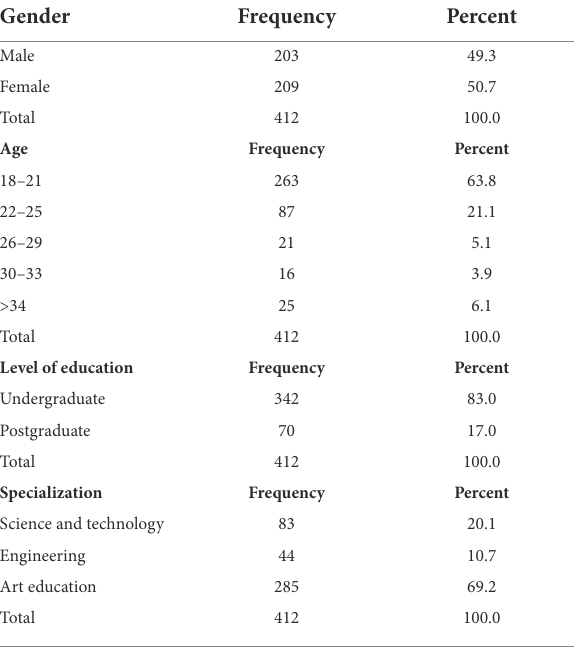
TABLE 1 Data collection and demographic